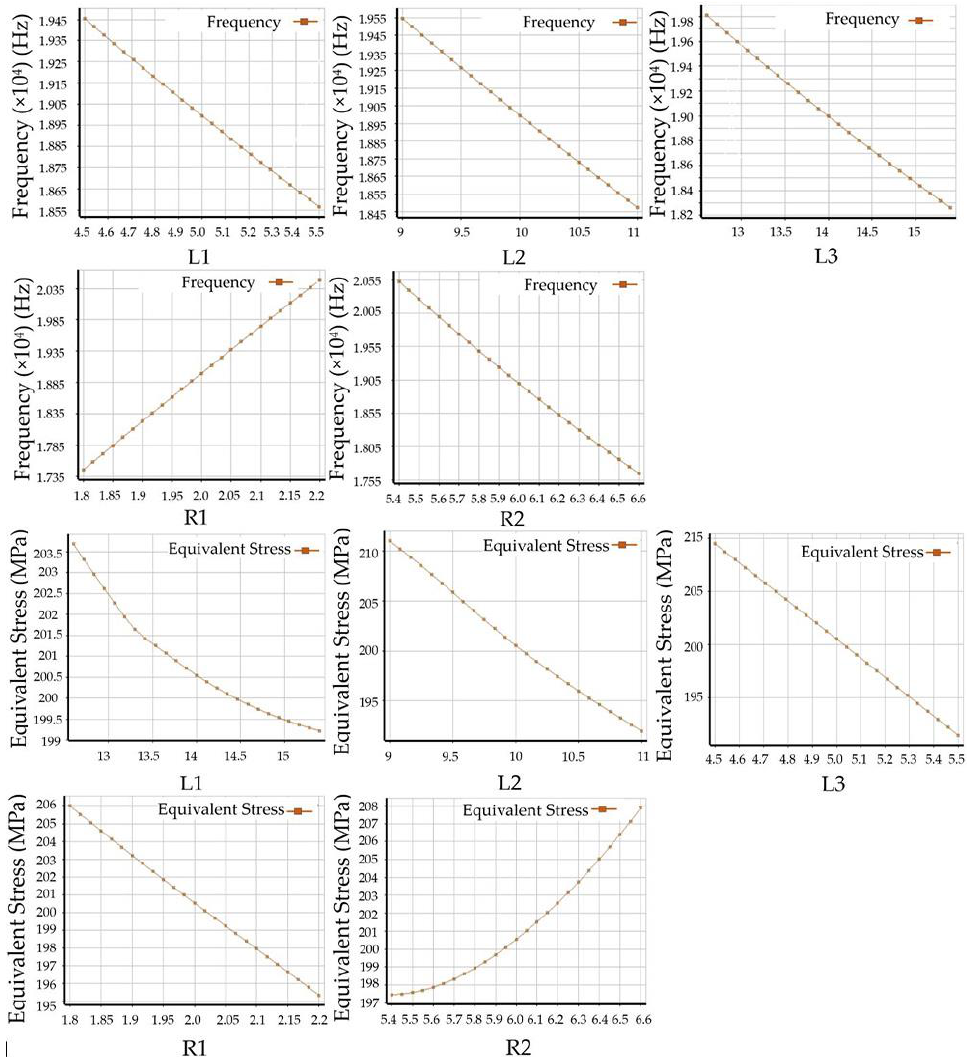
Figure 9. The influence trend diagram of sample size parameters on the design results.